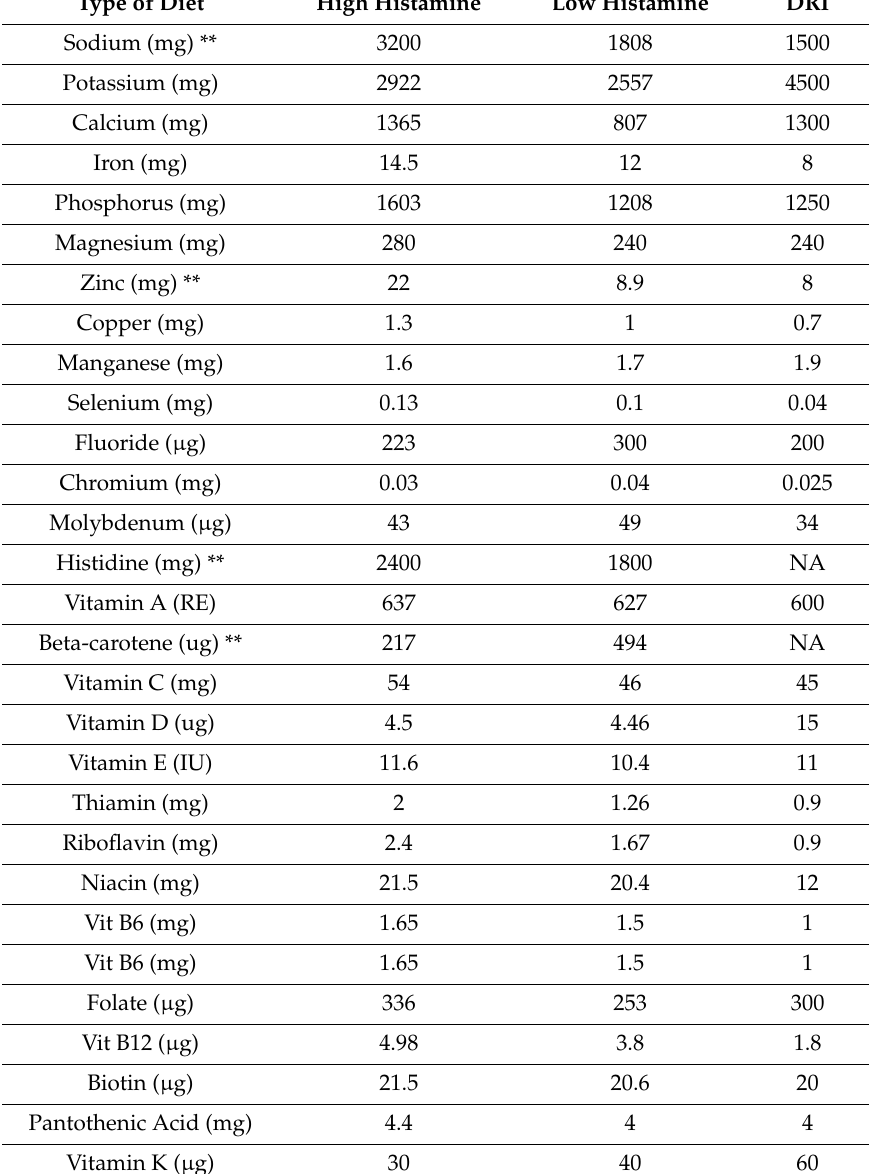
Table 5. Comparison of micronutrient intake (mean values) with Dietary Reference Intake